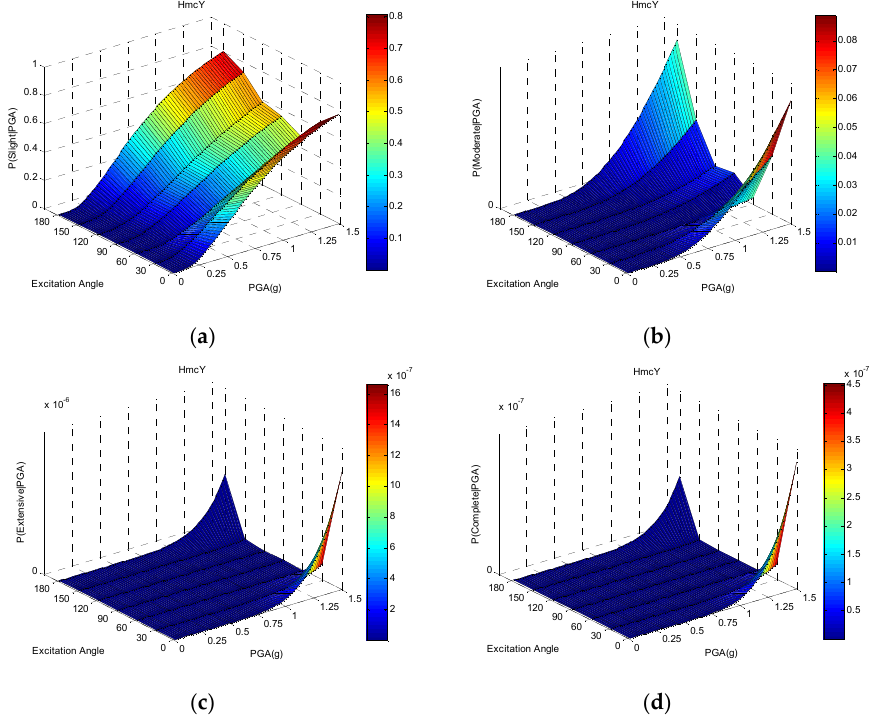
Figure A4. Seismic fragility surfaces of HmcY subjected to different excitation angles in the ( a ) slight; ( b ) moderate; ( c ) extensive; and ( d ) complete limit states.